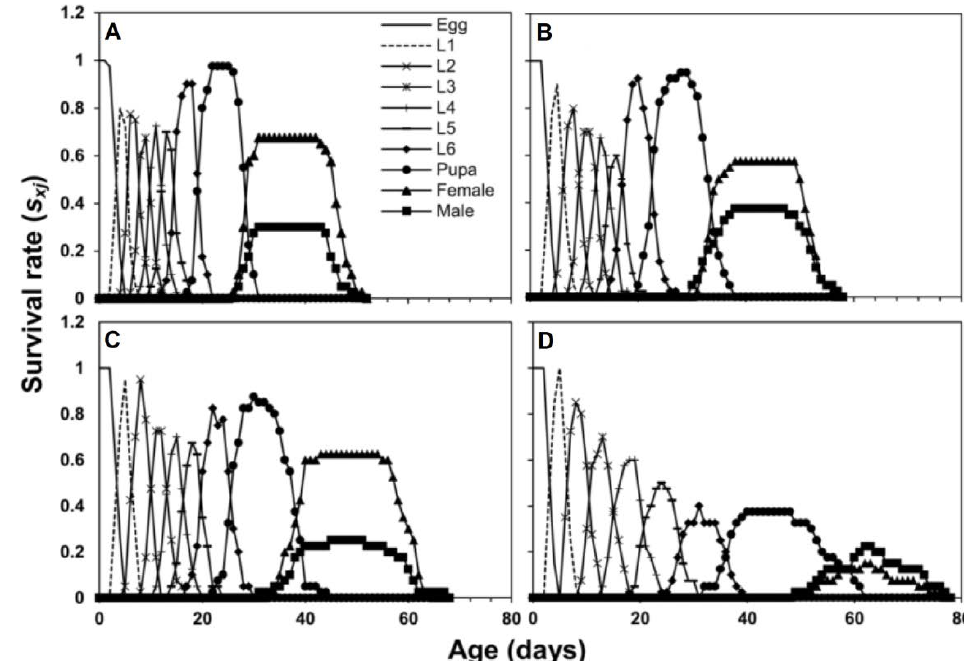
Figure 1. Age stage-specific survival rate ( s xj ) of S. frugiperda fed on four host plants, maize ( A ), sorghum ( B ), wheat ( C ) and rice ( D ).